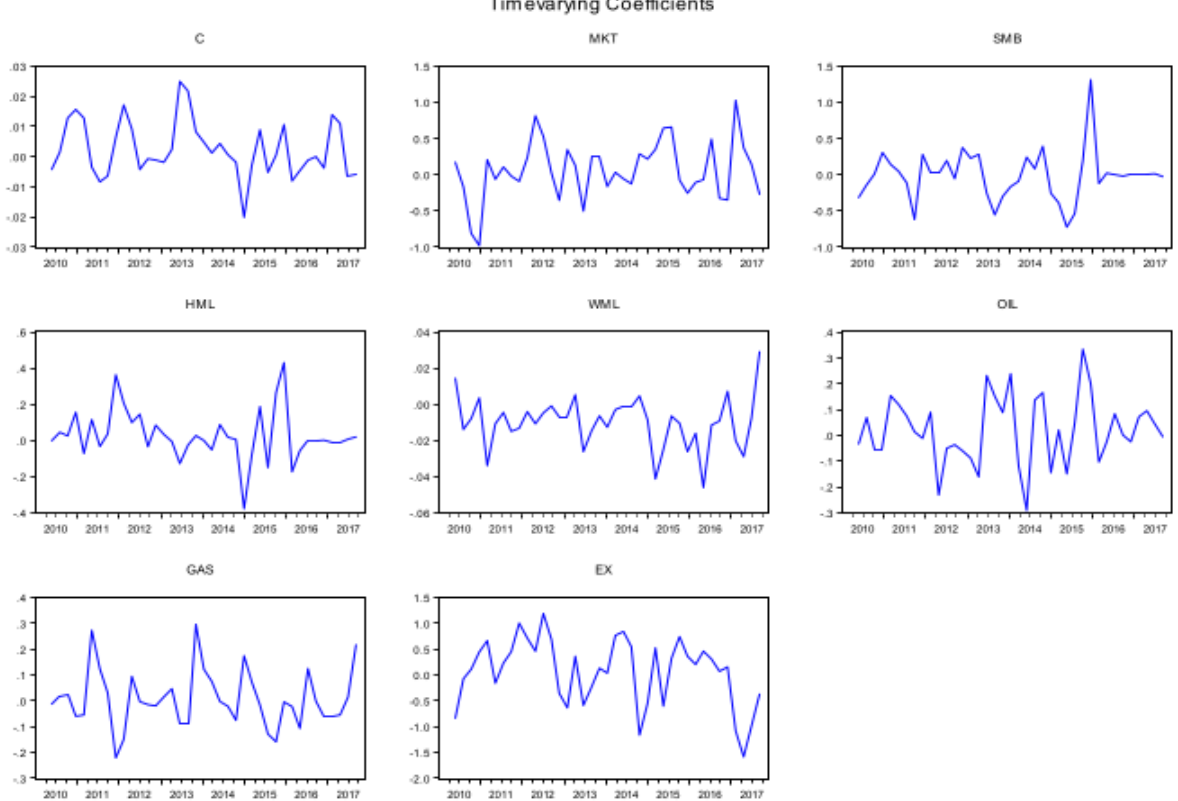
Figure 1. Rolling betas of risk factors for the oil and gas industry